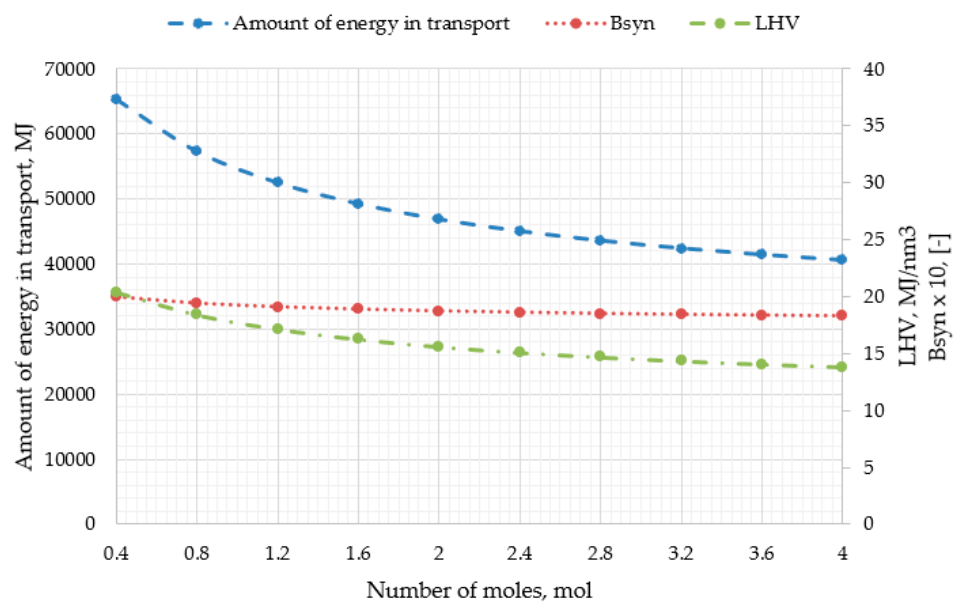
Figure 23. Amount of energy in the transport, LHV , and B syn coefficient for syngas obtained as a result of gasification using H 2 at a temperature of 973 K.